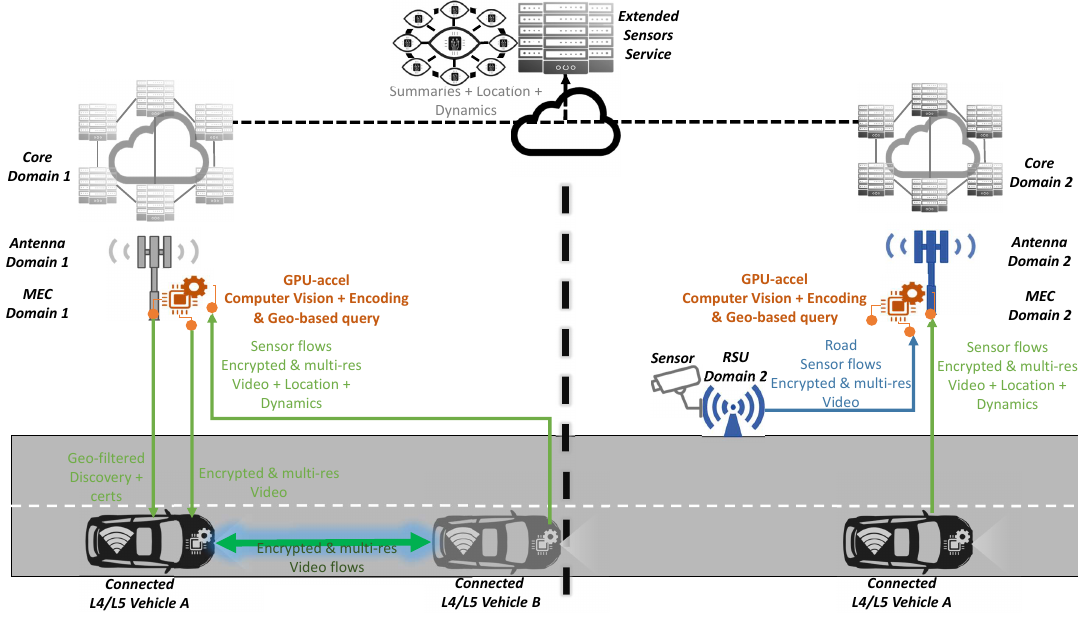
Figure 6. Extended sensors scenario of the proposed